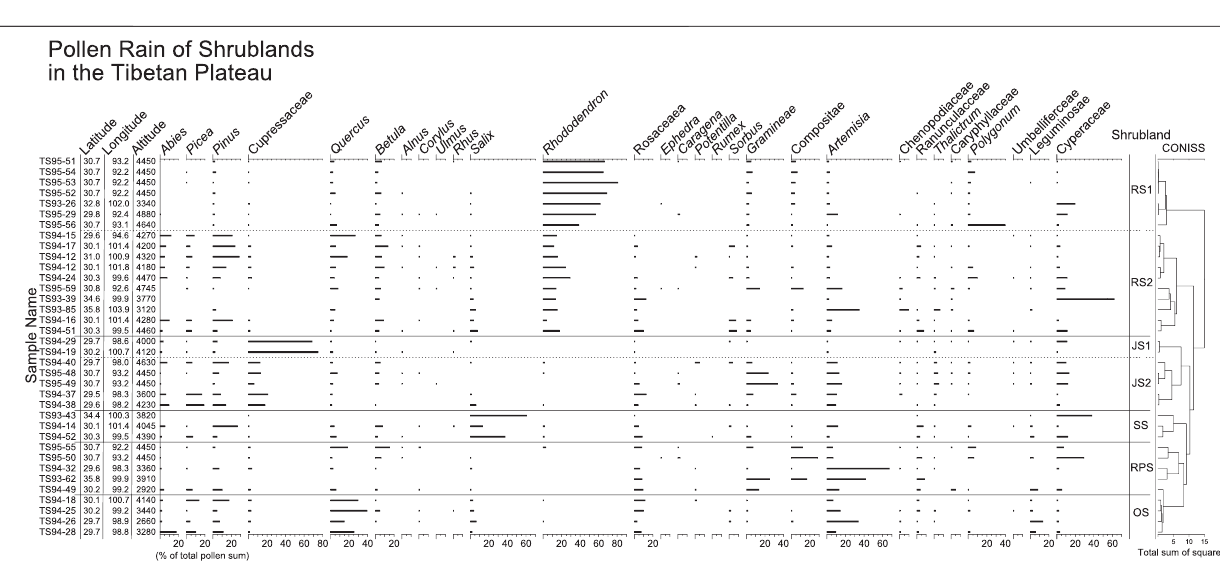
Frontiers in Earth Science |